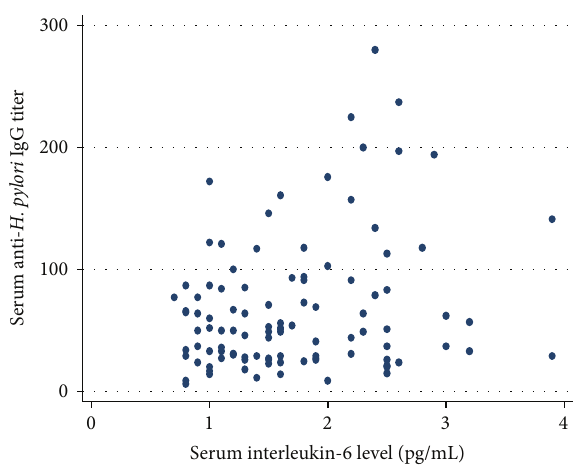
Figure 2: Correlation between serum interleukin-6 and anti- H. pylori IgG titers among women ( 𝑟 = 0.23 , 𝑃 = 0.021 , and 𝑛 = 104